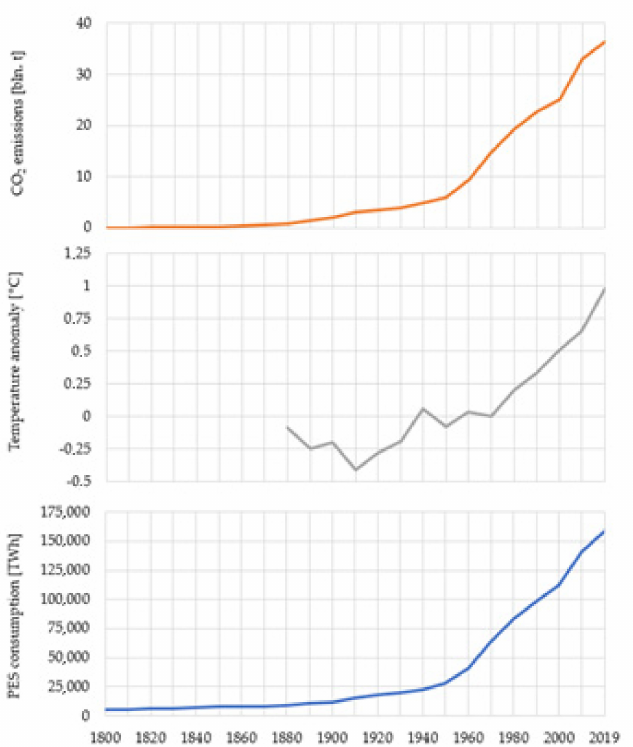
Figure 2. Development of primary energy consumption, CO 2 emissions and global temperature anomaly (1800–2019)